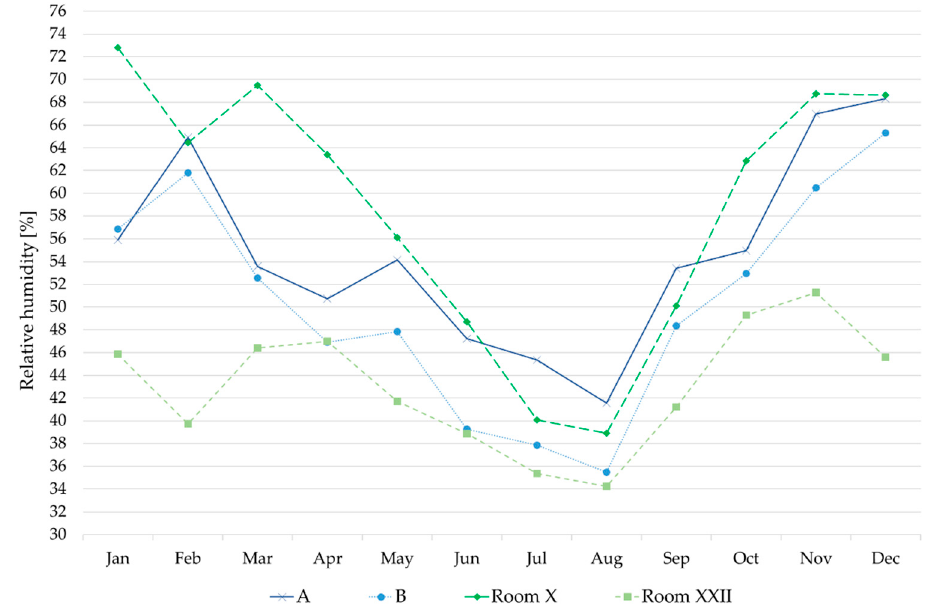
Figure 27. Trend of average indoor monthly relative humidity (RH) measured in the analyzed zones of Vasari Corridor and La Specola museum.